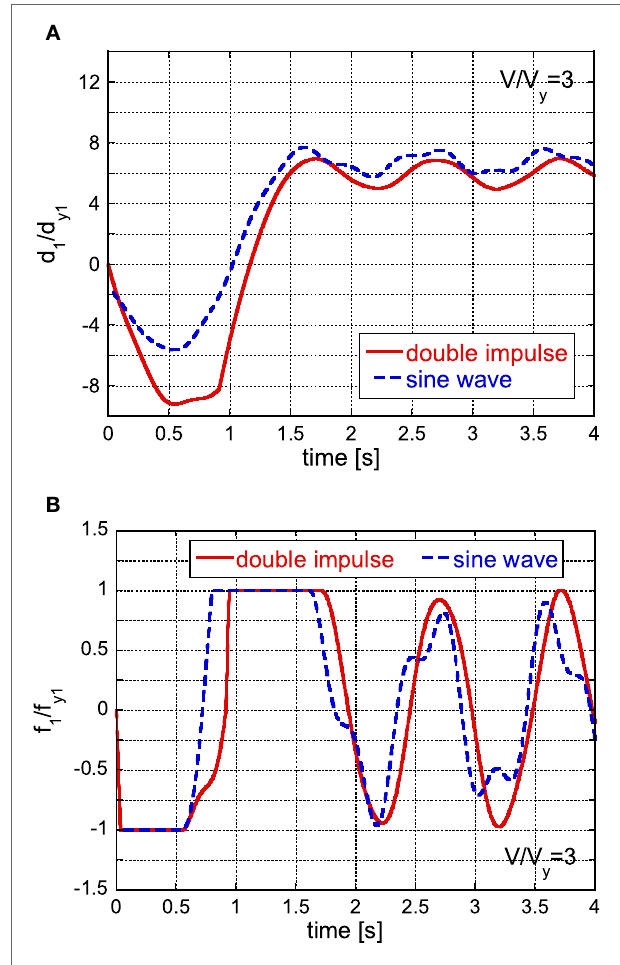
FigUre a1 | adjustment of input level of double impulse and the corresponding one-cycle sinusoidal wave based on Fourier amplitude